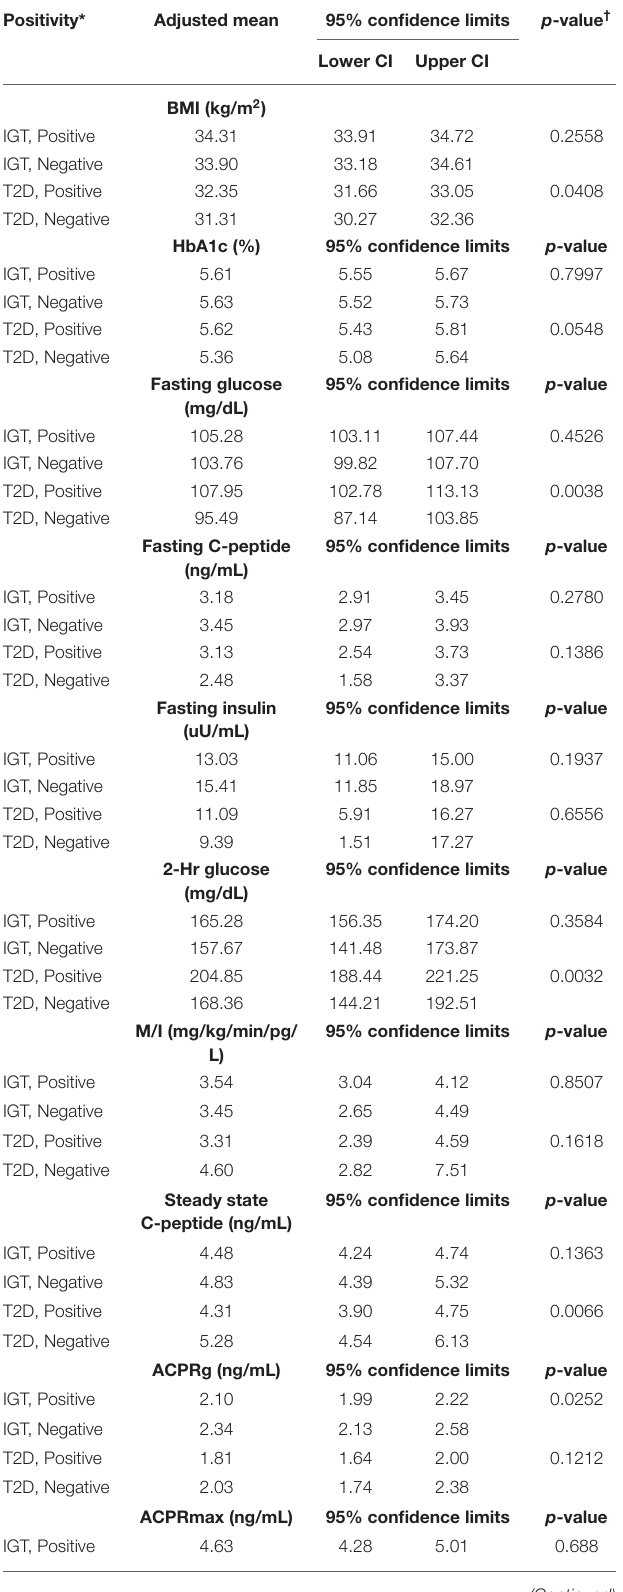
TABLE 2 | Relationship of T cell positivity with month-12 outcomes in participants with T2D and participants with IGT. Positivity*